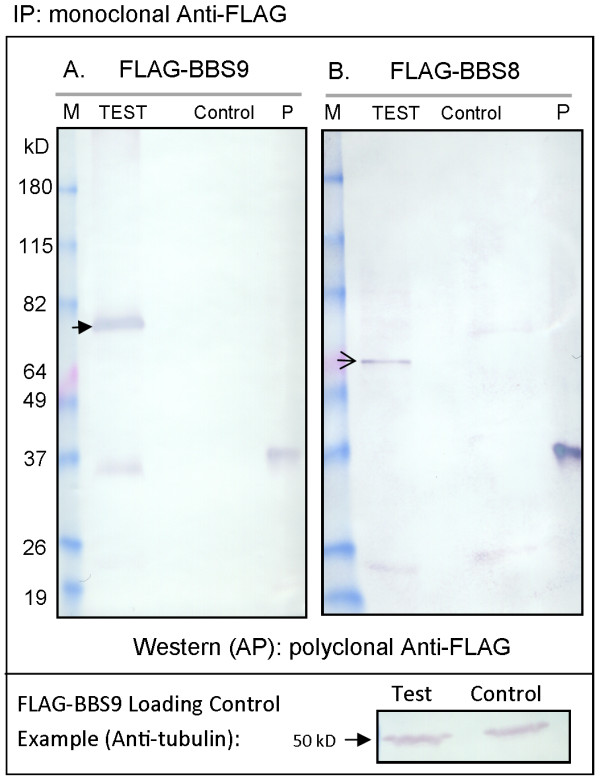
Immunoprecipitation (IP) of FLAG-BBS9 or FLAG-BBS8 proteins from whole cell extracts (WCEs). Proteins were immunoprecipitated using anti-FLAG affinity beads and western blots were developed (AP) using polyclonal anti-FLAG. (A) IP from cells expressing FLAG-BBS9 (Test) and control cells expressing the FLAG plasmid (Control). Closed arrow indicates FLAG-BBS9. (B) IP from cells expressing FLAG-BBS8 (Test) and control cells expressing the FLAG plasmid (Control). Open arrow indicates FLAG-BBS8. Both blots show a molecular weight marker (M) and a 37 kDa FLAG-fusion protein as a positive control (P). Below is an example of a loading control from the FLAG-BBS9 IP. Protein concentrations were determined using a Pierce assay before solubilization to ensure equal amounts of protein were used for both the Test and Contol IP. The loading control blot was probed with anti-tubulin (50 kD).